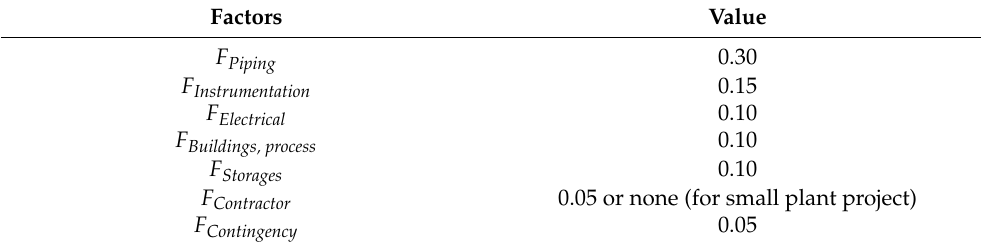
Table 2. Typical factors for the estimation of project fixed capital cost